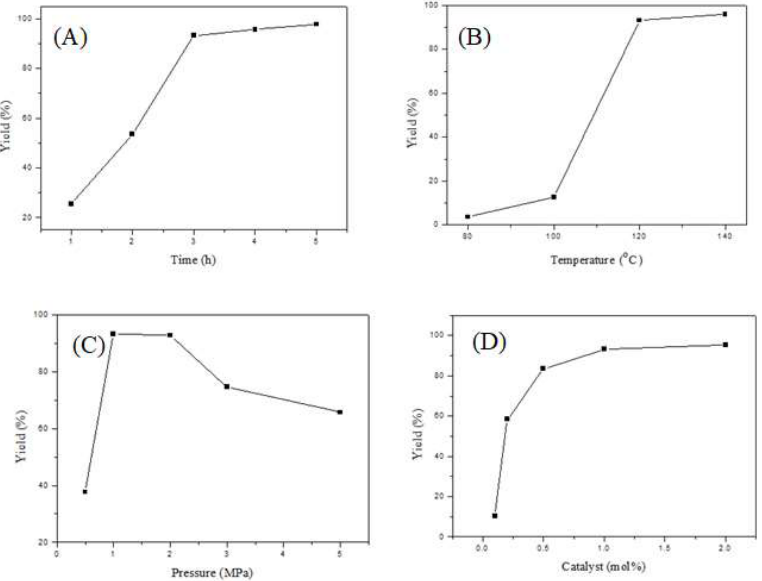
Figure 1. Effects of different reaction parameters on PC yield. ( A ) Reaction time effect on PC yield: PO (10 mL,0.143 mol), catalyst Zn-NPClH (1.43 mmol,1 mol%), T = 120 °C, P = 1 MPa; ( B ) Reaction temperature effect on PC yield: PO (10 mL, 0.143 mol), catalyst Zn-NPClH (1.43 mmol, 1 mol%), t = 3 h, P = 1 MPa; ( C ) CO 2 pressure effect on PC yield: PO (10 mL, 0.143 mol), catalyst Zn-NPClH (1.43 mmol,1 mol%), t = 3 h, T = 120 °C; ( D ) The mole ratio of PO to catalyst effect on PC yield: PO (10 mL, 0.143 mol), catalyst Zn-NPClH (1.43 mmol), t = 3 h, T = 120 °C, P = 1 MPa. The selectivity of PC was >99%.